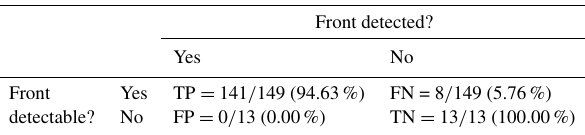
Table 1. Confusion matrix: CALFIN-NN misses fronts in 8 of 149 valid CALFIN-VS images, but this trade-off is